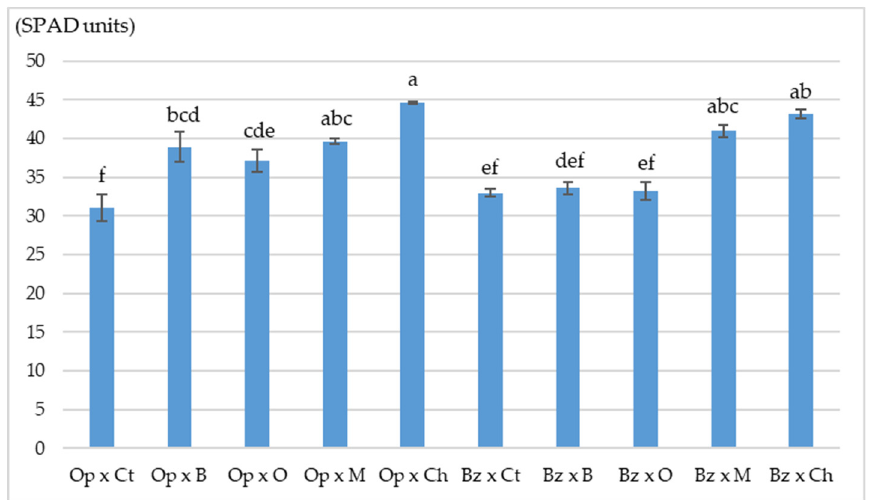
Figure 1. Chlorophyll content in basil leaves expressed as soil plant analysis development (SPAD) units, as affected by the interaction between cultivar and fertilization. Opal (Op); De Buzau (Bz); control (Ct); biosolids (B); organic (O); microorganisms (M); chemical (Ch). Values associated with different letters are significantly different according to Tukey’s test at p < 0.05.